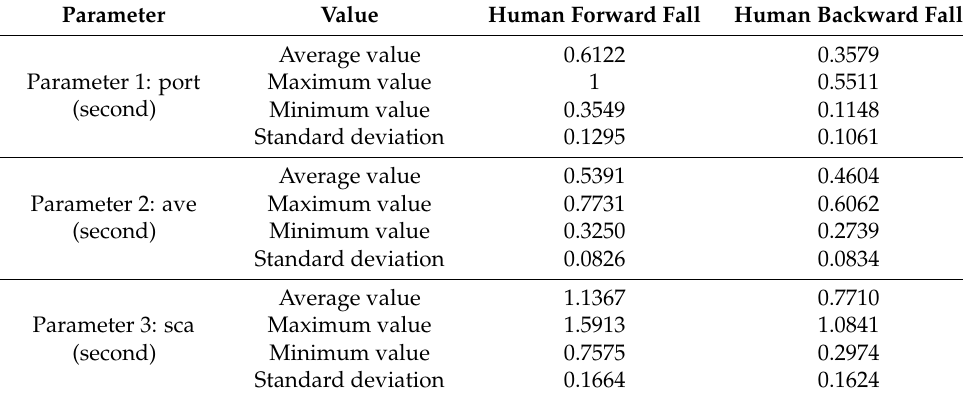
Table 8. Performance of selected parameters in different datasets.